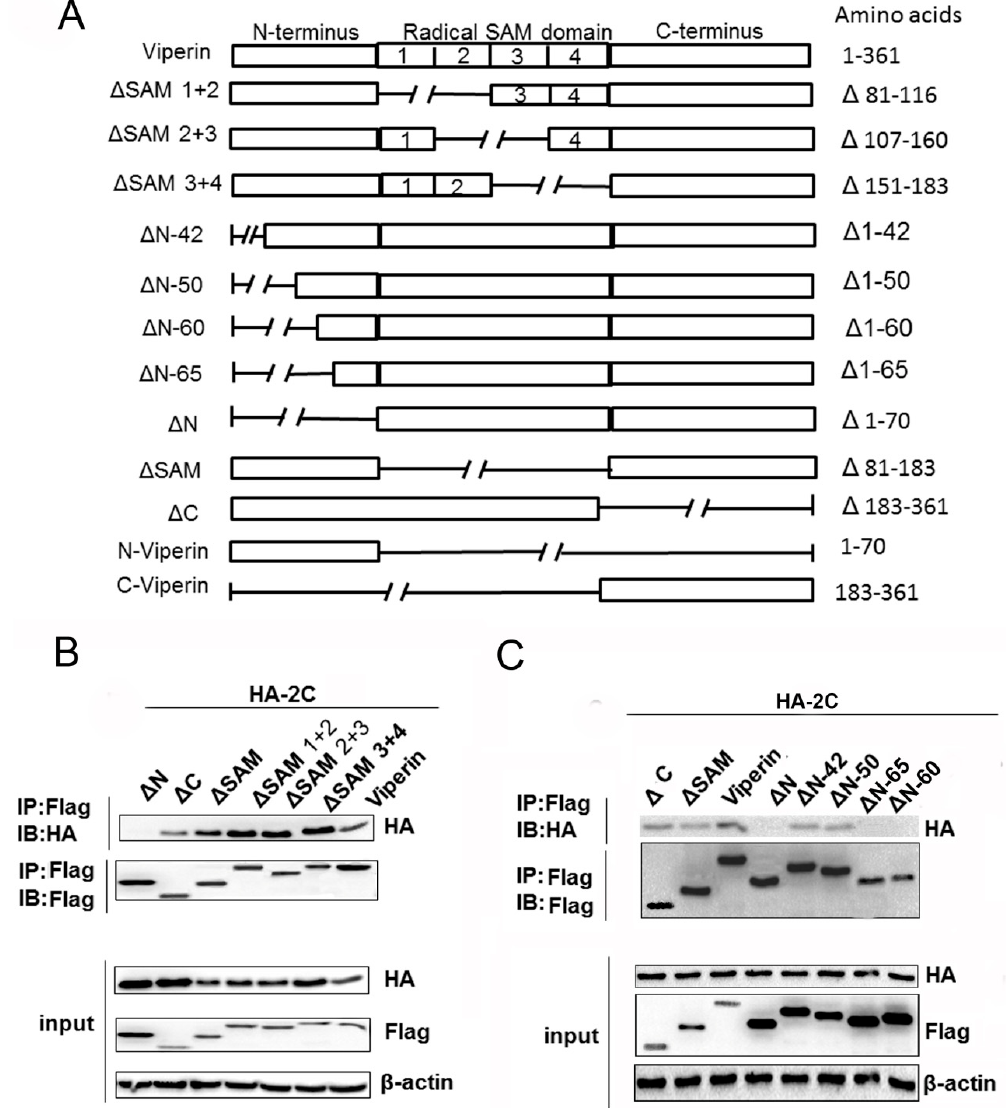
Figure 6. The N-terminal domain is responsible for viperin binding to 2C. ( A ) Schematic diagram of a series of viperin deletion mutants. ( B ) FLAG-viperin, Δ SAM3+4, Δ SAM2+3, Δ SAM1+2, Δ SAM, Δ C, or Δ N were co-transfected with HA-2C into 293T cells for 24 h. The cells were then lysed, followed by co-IP and immunoblotting assays. ( C ) 293T cells were co-transfected HA-2C with Δ C, Δ SAM, viperin, Δ N, Δ N-42, Δ N-50, Δ N-65, or Δ N-50 for 24 h, and then the cells were lysed and used for co-IP and immunoblotting.